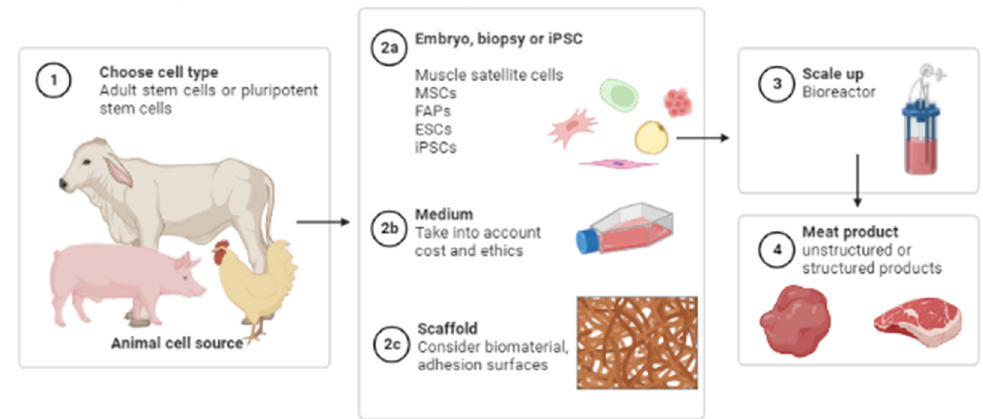
Figure 3. A general workflow for cultivated meat production.